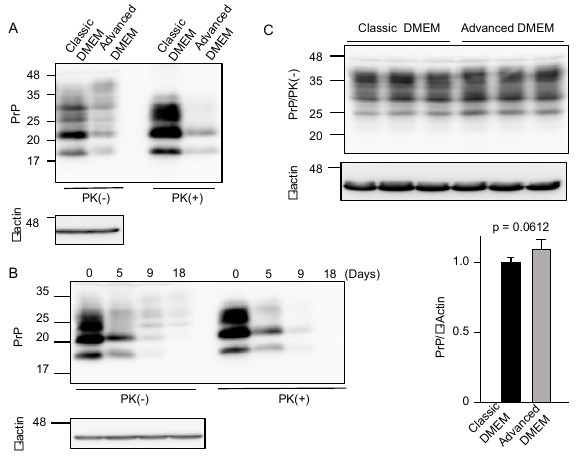
Figure 1. Advanced DMEM reduces PrP Sc levels in prion-infected cells. ( A ) Western blotting with 6D11 anti-PrP antibody of proteinase K (PK)-treated or -untreated cell lysates from prion-infected N2aC24L1-3 cells cultured in classic or advanced DMEM for 6 days. β -actin is an internal control. ( B ) Western blotting with 6D11 anti-PrP antibody of PK-treated or -untreated cell lysates from N2aC24L1-3 cells cultured in advanced DMEM for the indicated days. β -actin is an internal